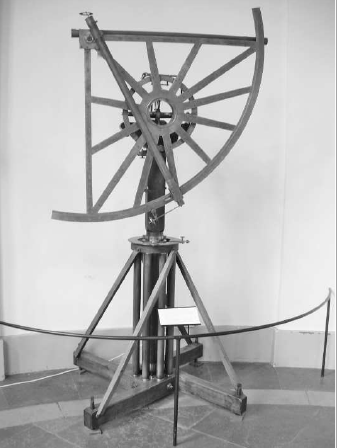
Fig. 2. The great quadrant by John Bird from 1757. Image: Michael Lindberg.